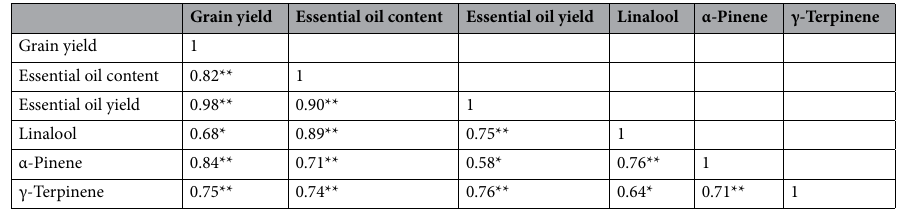
Table 5. Pearson’s correlation factors (coefficients) between total grain yield, essential oil content, essential oil yield, and chemical composition of coriander essential oil influenced by the chemical and organic fertilizers × humic acid application. *, **, Significant at 5 and 1% probability levels, respectively.